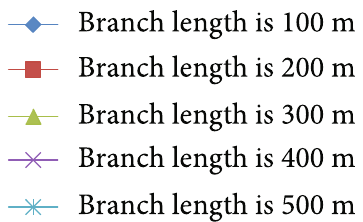
(b) Lateral well position is 50m from the heel of main wellbore Figure 7: